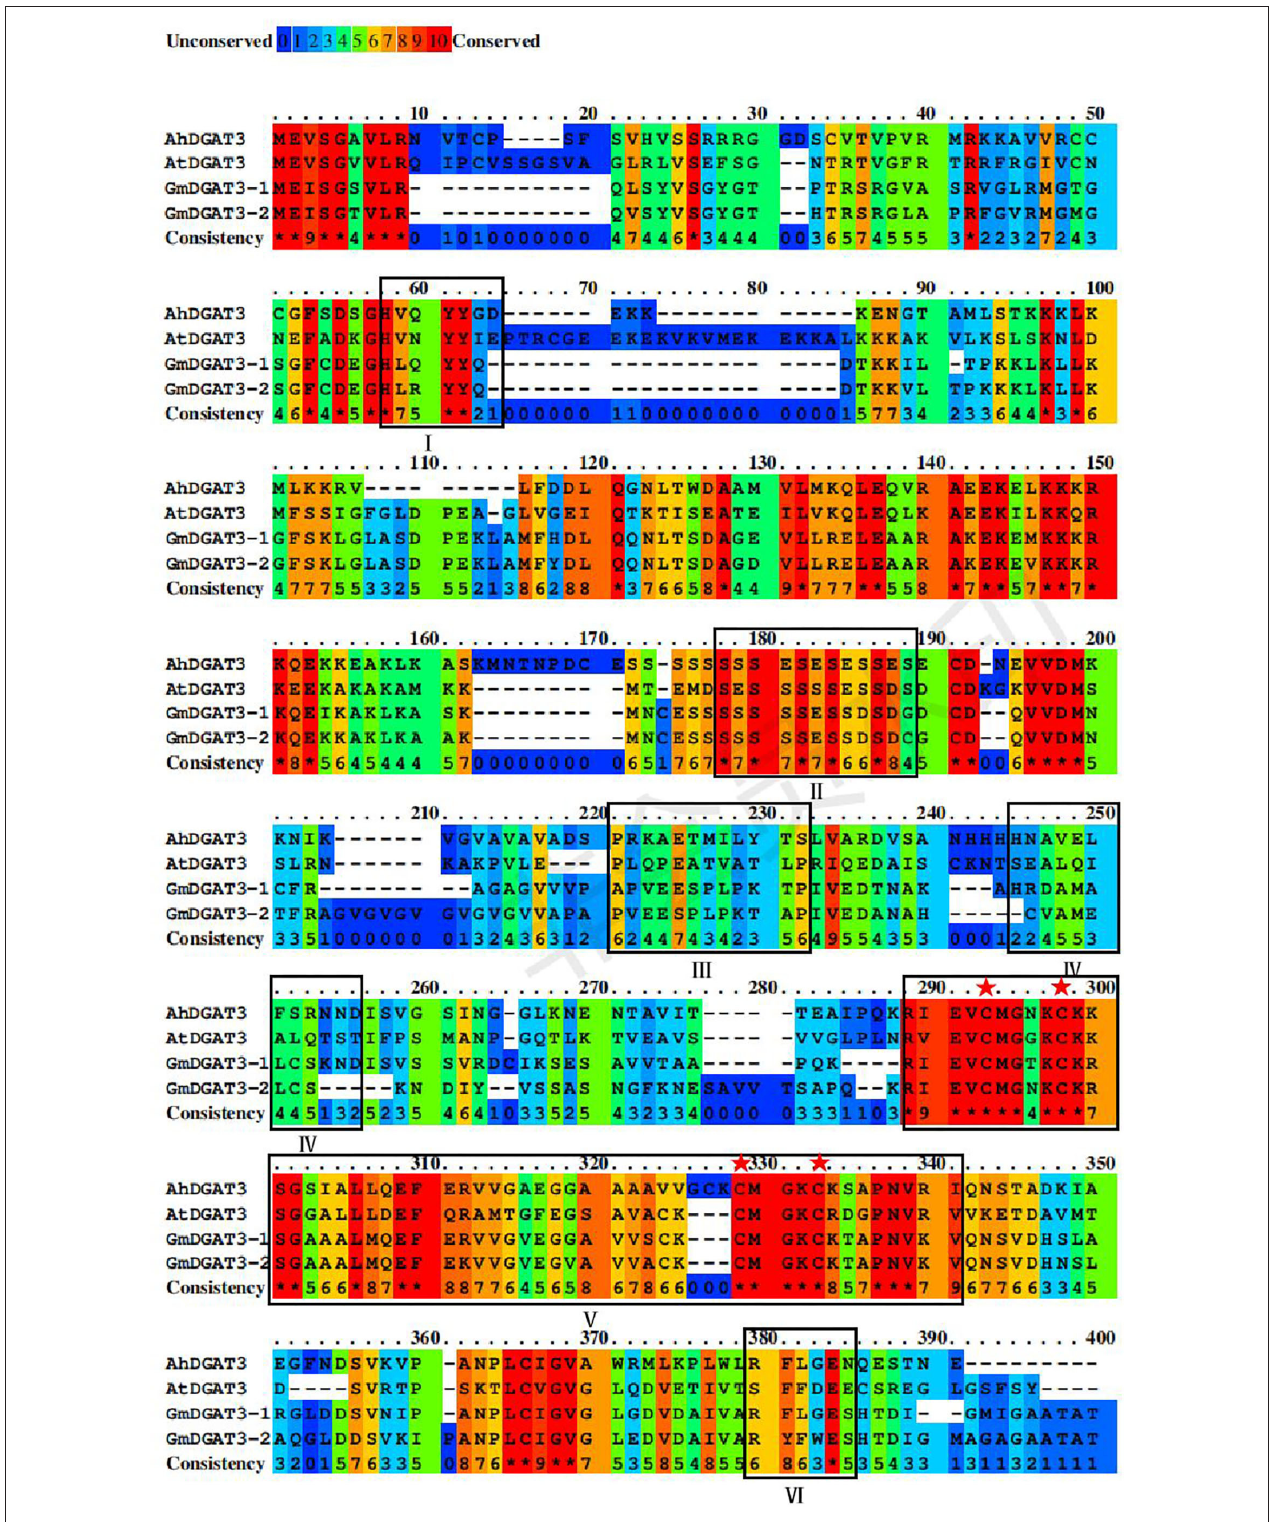
FIGURE 1 | Sequence alignment of GmDGAT3, AhDGAT3-1, and AtDGAT3 proteins. The conserved amino acids were denoted by different colors, and residues in red represent 100% conservation of all sequences. The conserved domains were framed and marked by I–VI. The potential DGAT motifs were marked as I and IV. DGAT catalytic motif was labeled as VI. A putative thiolase acyltransferase intermediate signature was labeled as II. A putative phosphorylation conservation site of Tyr (tyrosine) kinase was designated as III. And the thioredoxin-like ferredoxin domain was a symbol as V with its conserved cysteine residues was highlighted with red